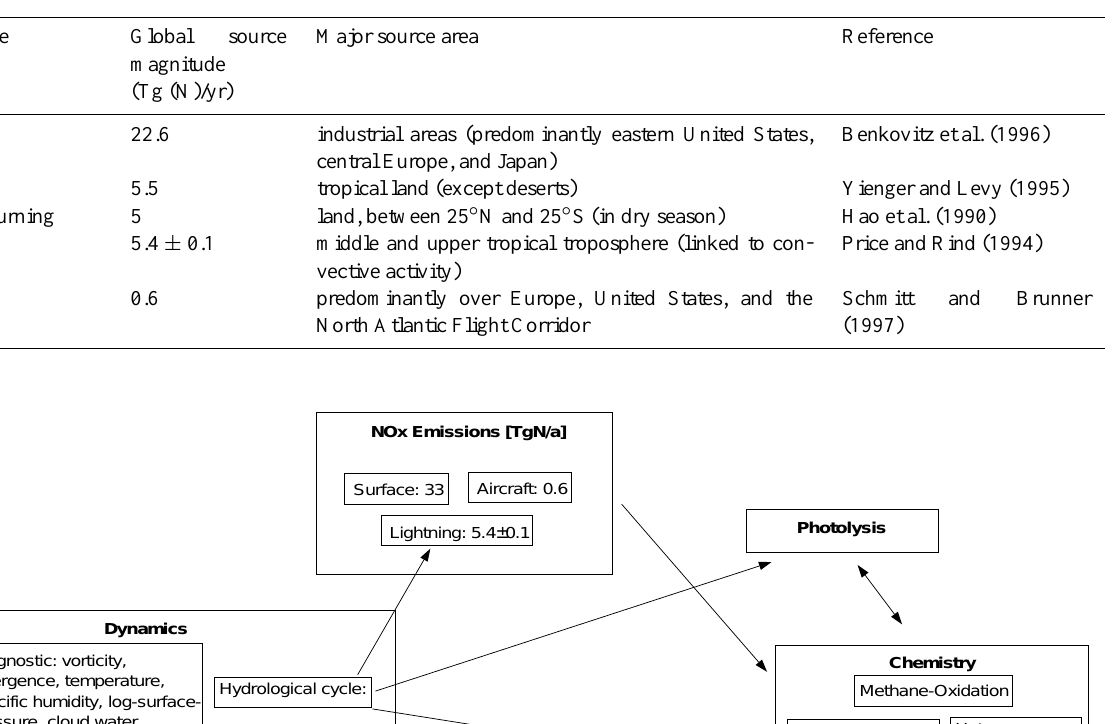
Table 2. Nitrogen Oxide emissions